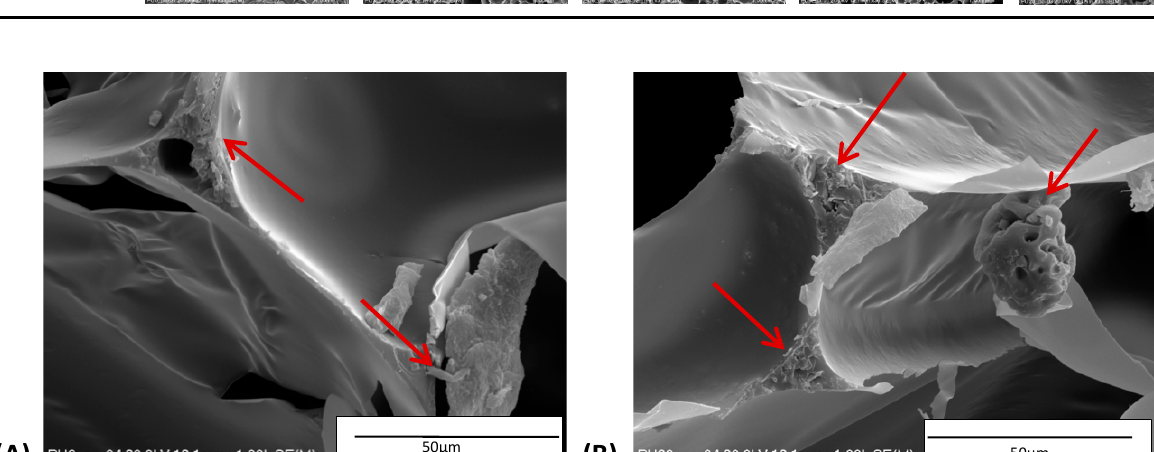
Figure 5. Embedding filler in struts ( A ) (PU/BioC-6), ( B ) (PU/BioC-20). Red arrow shows where the filler is embedded.